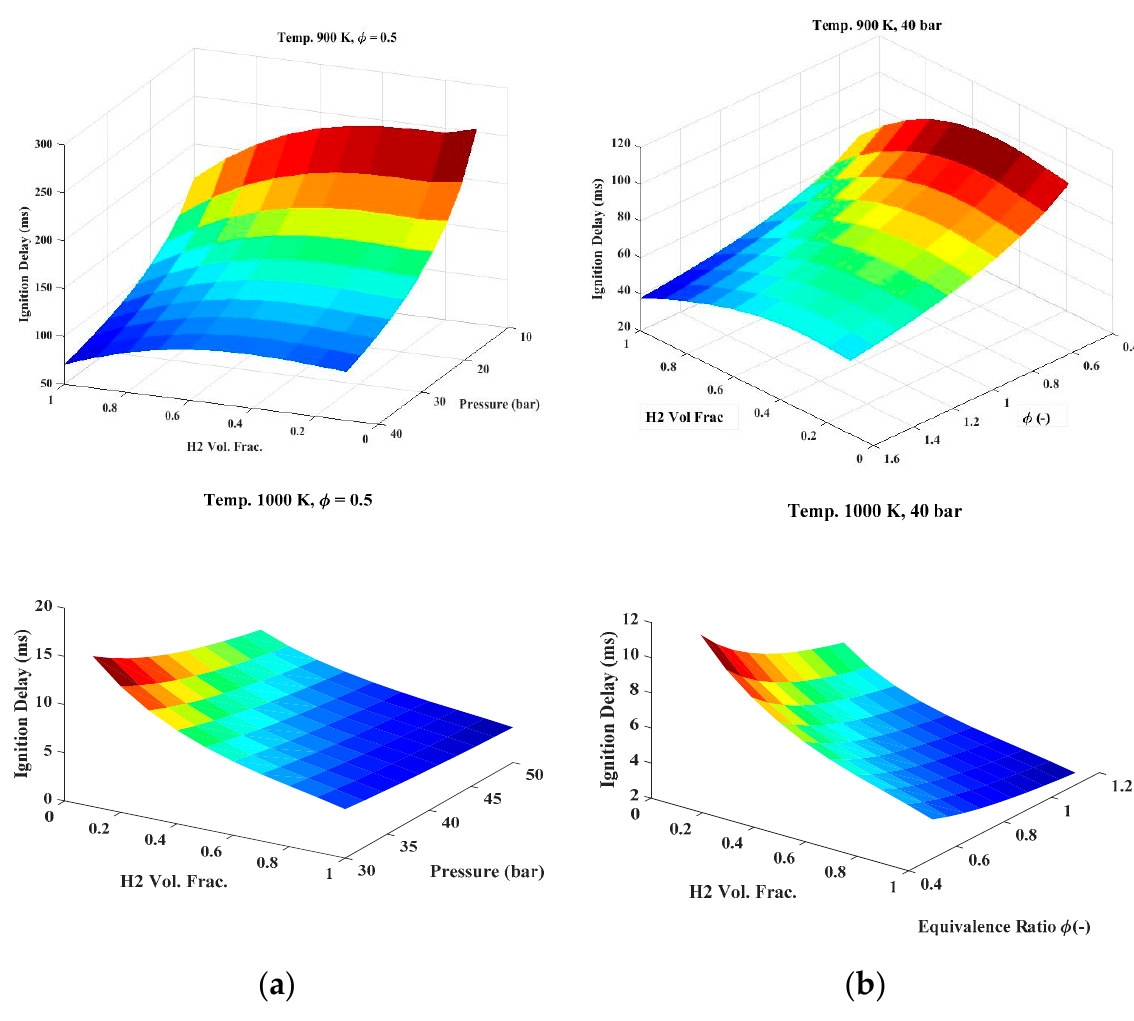
Figure 11. Effect of H 2 addition on methane’s ignition delay times at: ( a ) different pressure at T = 900 and 1000 K, Φ = 0.5; ( b ) different equivalence ratios at T = 900 and 1000 K, p = 40 bar.